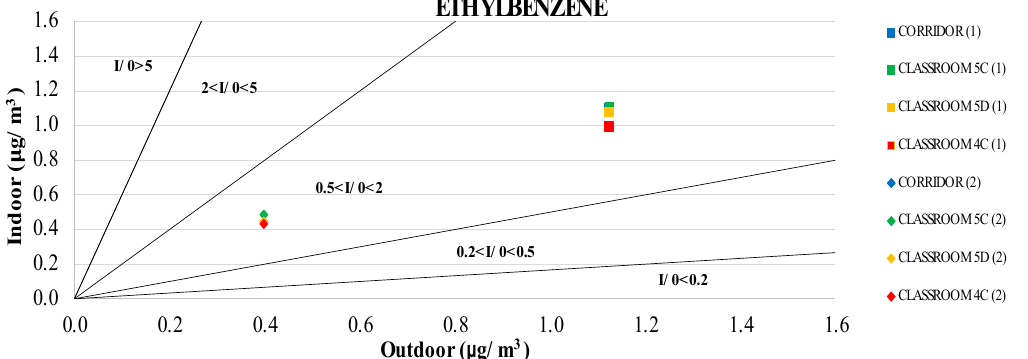
Figure 3. Ethylbenzene indoor concentrations against outdoor concentrations in all monitored sites during the first (1) and the second (2) monitoring periods.